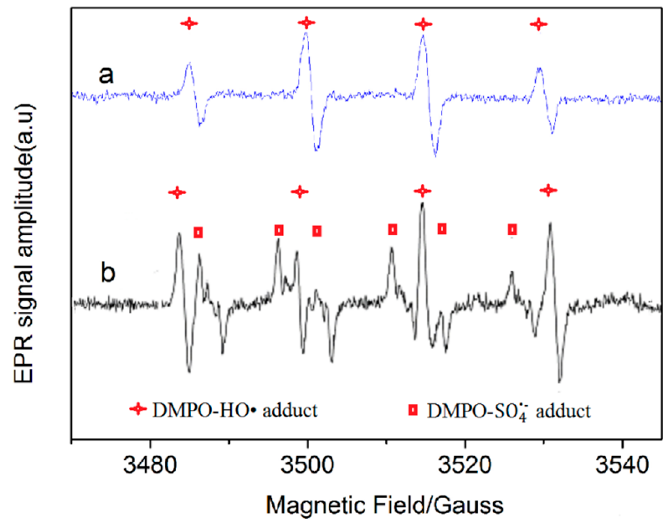
Figure 5. Electron paramagnetic resonance (EPR) spectra obtained from ( a ) BiOBr/H 2 O 2 and ( b ) BiOBr/PMS systems in the presence of DMPO. BiOBr dose 0.5 g ∙ L − 1 , [DMPO] 0 = 100 mM, [CBZ] 0 = 5 μ M, [PMS] 0 = 4.0 mM, pH = 7.0, T = 24 °C.